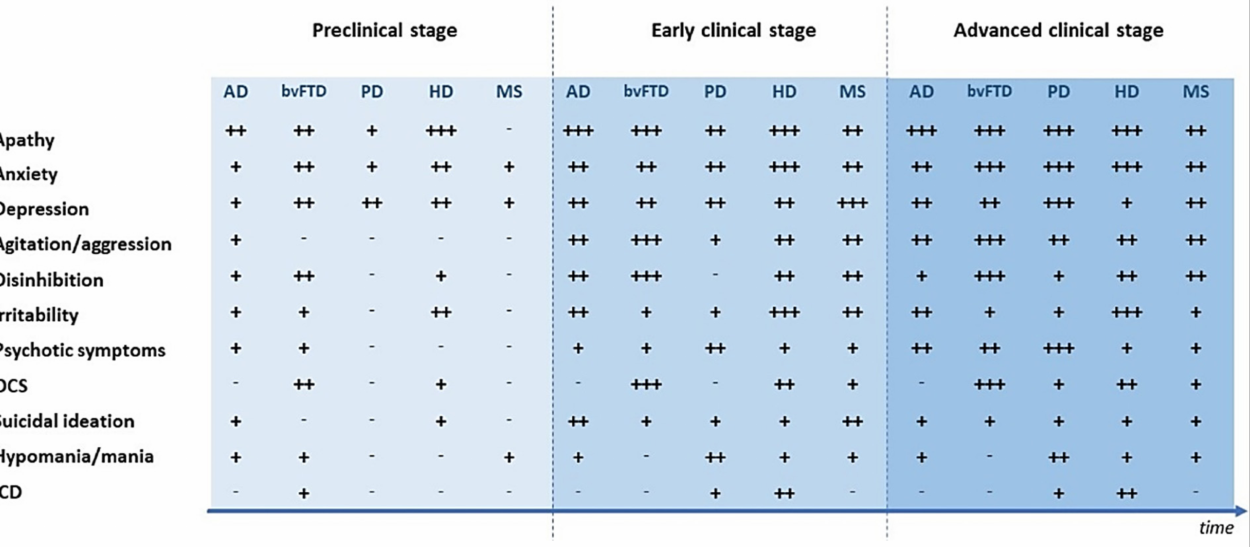
Figure 1. Psychiatric symptoms during different stages of neurodegenerative and neuroinflammatory diseases. AD = Alzheimer’s disease; bvFTD = Behavioral variant of fronto-temporal dementia; HD = Huntington’s disease; MS = Multiple sclerosis; PD = Parkinson’s disease; ICD = Impulse control disturbances; OCS = Obsessive-compulsive symptoms. - = Not reported; + = Prevalence <25%; ++ = Prevalence 25–50%; +++ = Prevalence